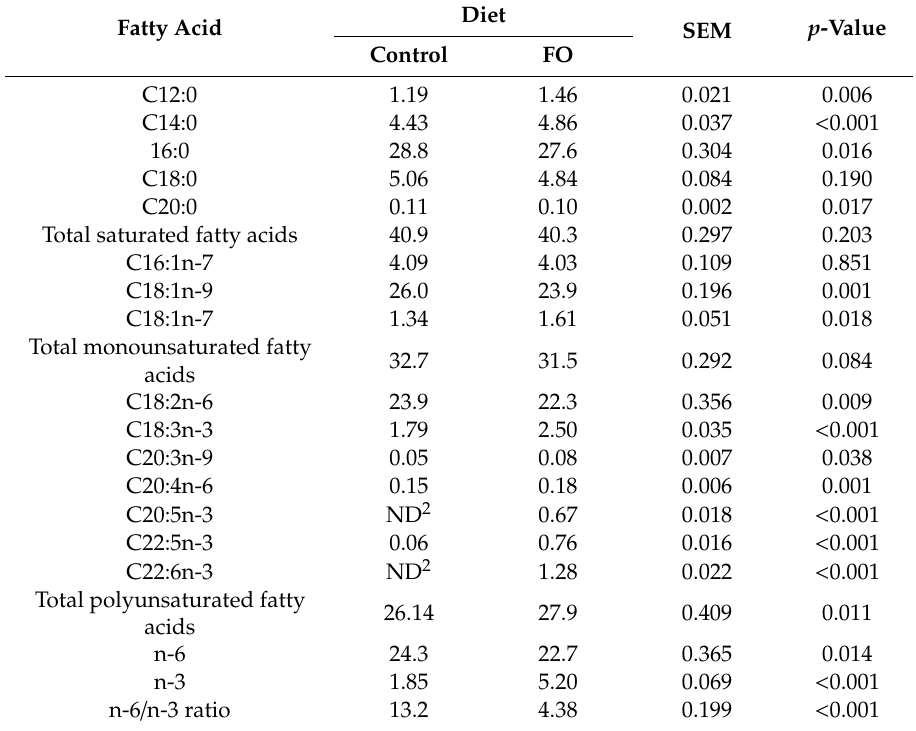
Table 5. Fatty acid profiles (g / 100 g total fatty acid methyl esters) of perirenal fat of growing rabbits fed diets with either lard (control) or fish oil (FO) as the fat source and slaughtered at 60 days of age 1 . Diet Fatty Acid SEM p -Value Control FO C12:0 1.19 1.46 0.021 0.006 C14:0